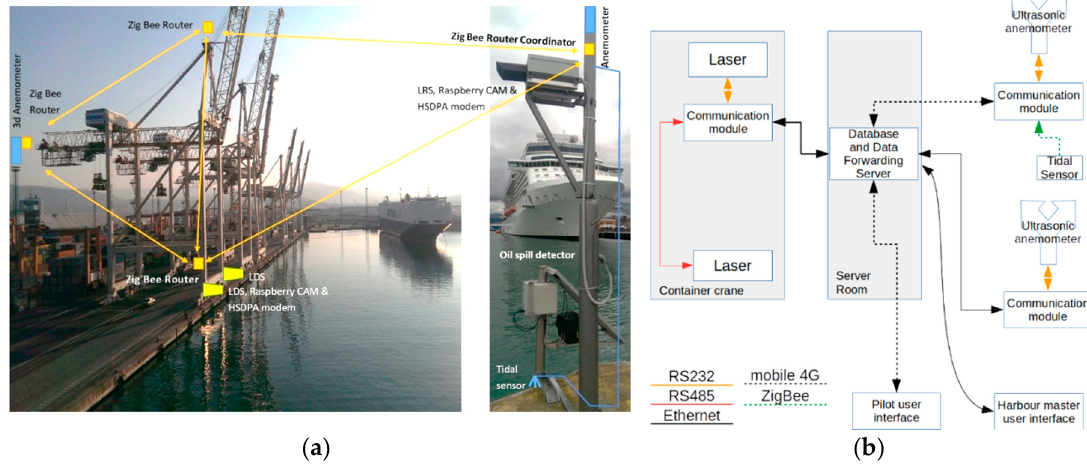
Figure 3. Laser ranging and berthing system ( a ) port of Koper installation, ( b ) communication protocol.